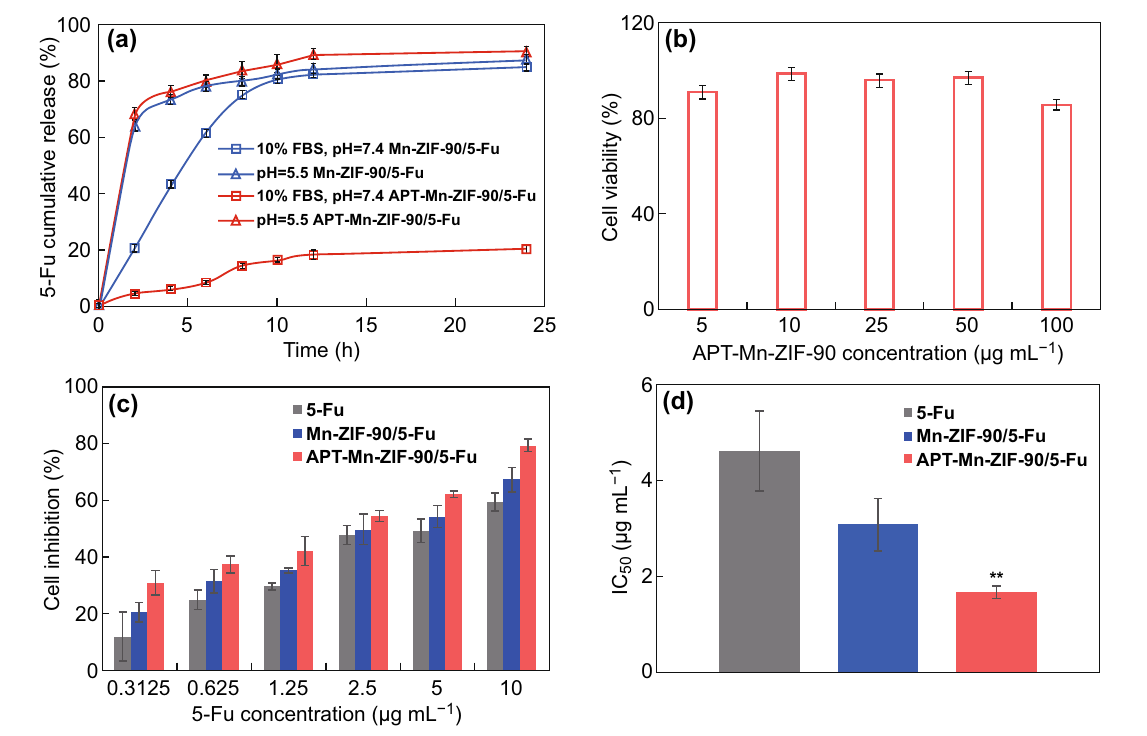
Fig. 3 a Cumulative release of 5-Fu from NPs in different environments (pH 7.4 + 10% FBS and pH 5.5) for 24 h in 37 °C in vitro; b cell viabil- ity of APT-Mn-ZIF-90 incubated with MCF-7 cells for 24 h; c cell inhibition effect and d IC 50 values of 5-Fu, Mn-ZIF-90/5-Fu, and APT-Mn- ZIF-90/5-Fu after incubation with MCF-cells for 24 h. Mean ± SD ( n = 3), ** p <